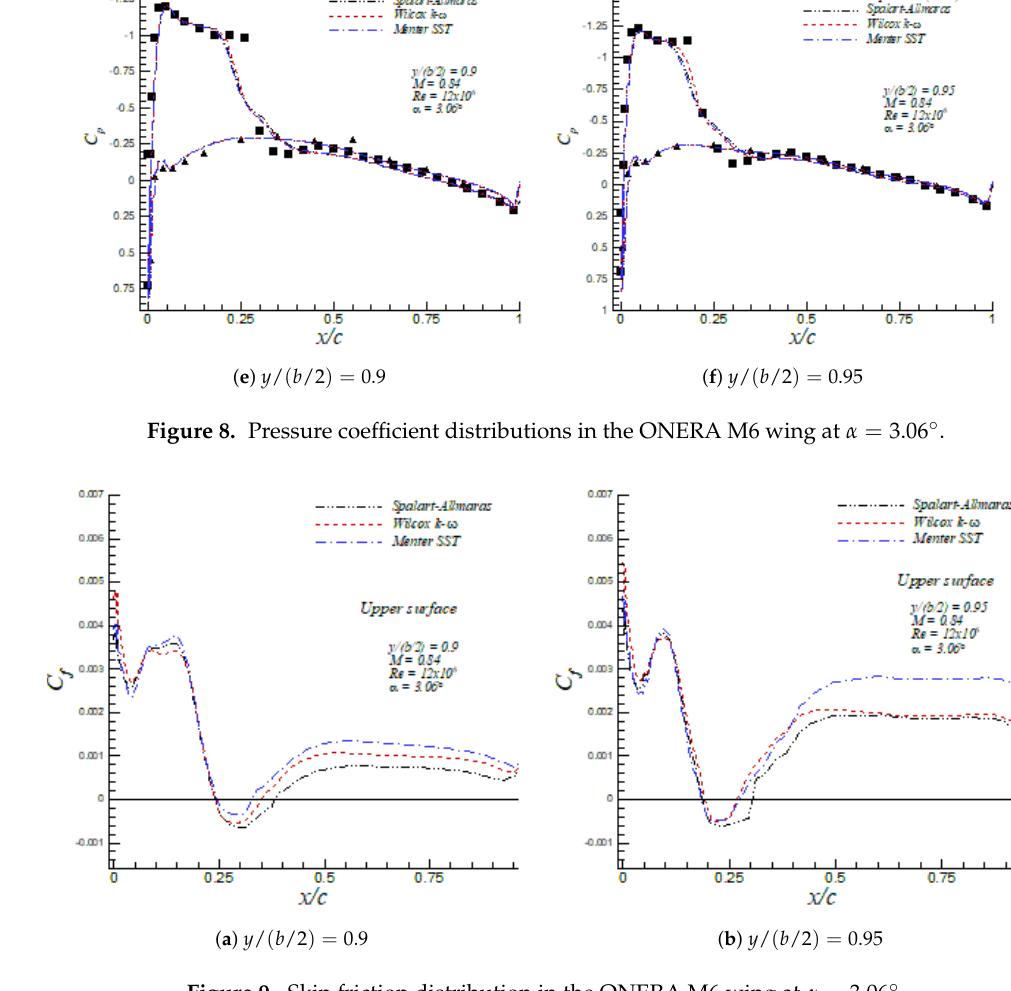
Figure 9. Skin friction distribution in the ONERA M6 wing at α = 3.06 ◦ . Table 3. Lift and drag coefficients in ONERA M6 wing at α = 3.06 ◦ . Aerodynamic